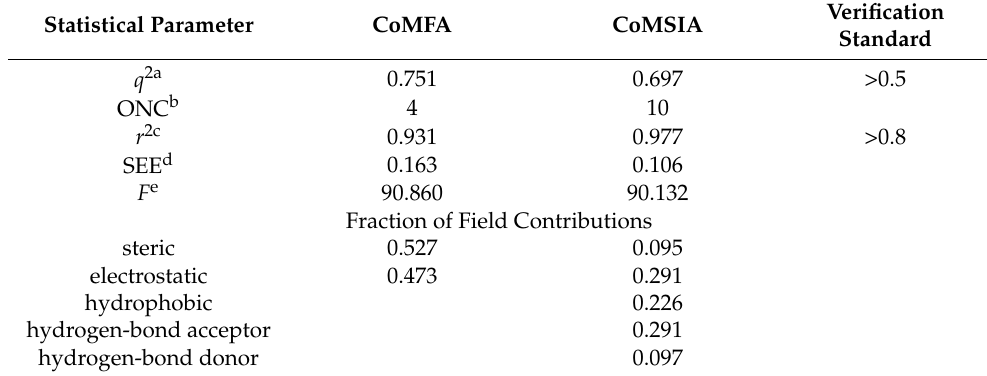
Table 2. Statistical results of the CoMFA and CoMSIA models.